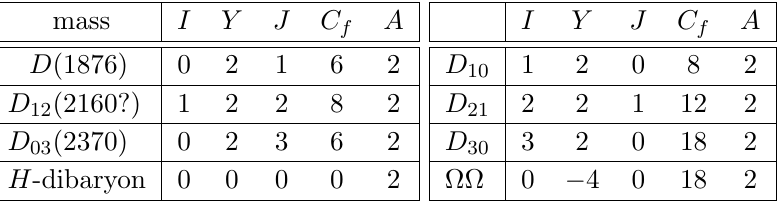
Table 3 . The list of hyperons, dibaryons and their